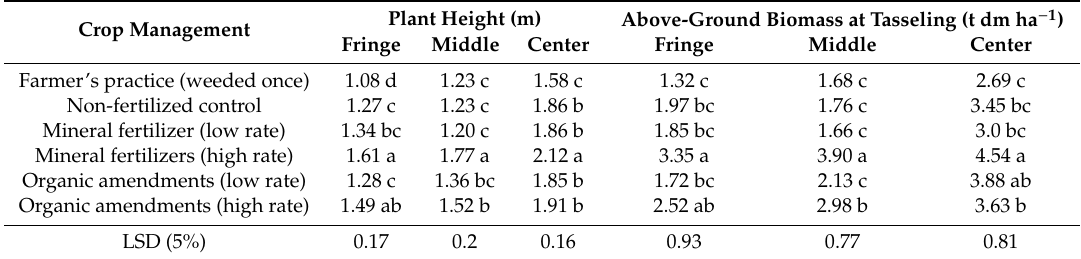
Table 2. Comparison of maize growth and biomass productivity under di ff erent crop management options at three hydrological positions (fringe, middle, and center) of an inland valley in Namulonge averaged over three seasons.